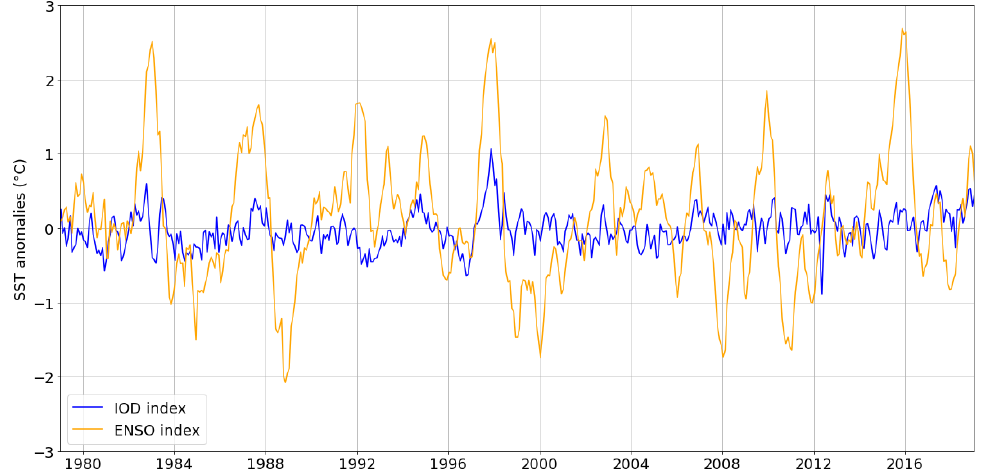
Figure 9. The IOD and ENSO indexes over the period 1980 to 2019. The ENSO index displays the SST anomalies for the El Nino 3.4 region in the Pacific (170° W–120° W, 5° S–5° N). The IOD index shows the SST anomalies calculated from the difference between the SSTs of the eastern area of the Indian Ocean (90° E–108° E, 10° S–0° S) and the SSTs of the western area (50° E–70° E, 10° S–10°